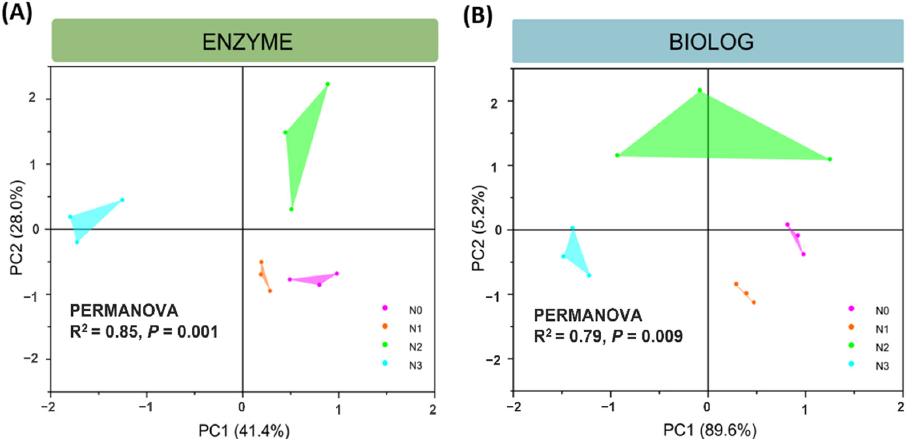
Figure 2. Principal component analysis (PCA) of Enzyme data ( A ) and Biolog profiles ( B ). Three replicates in the same color block represent a treatment. The p values between treatments refer to PERMANOVA